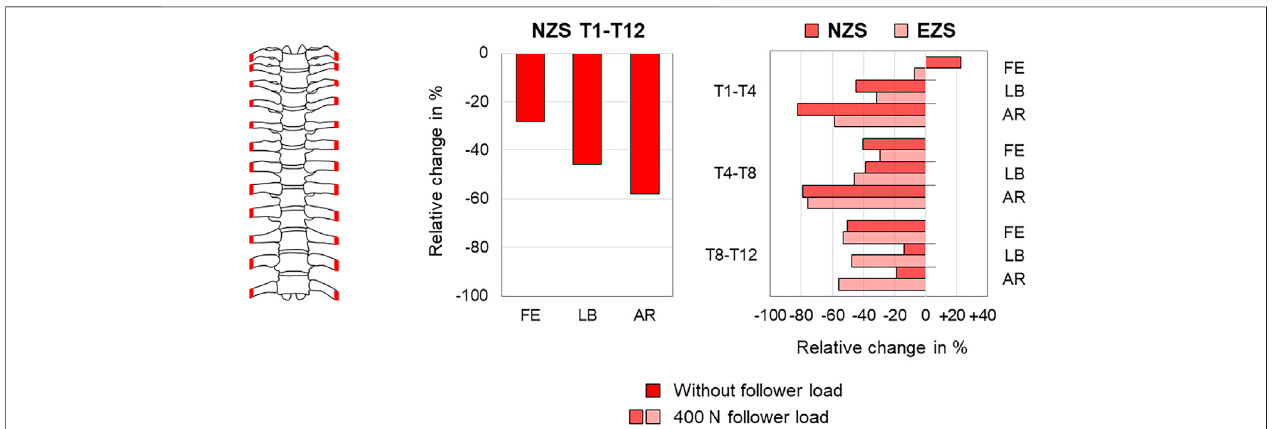
FIGURE10| Anterior rib cage removal. The relative neutral (NZS) and elasticzone stiffness (EZS)changesofthe thoracic spine (T1-T12and T1-T4/T4-T8/T8-T12) during fl exion/extension(FE),lateralbending(LB),andaxialrotation(AR)afteranteriorribcageremovalwithoutfollowerloadaccordingtoMannenetal.(2015b)andwith a follower load of 400 N according to Mannen et al.